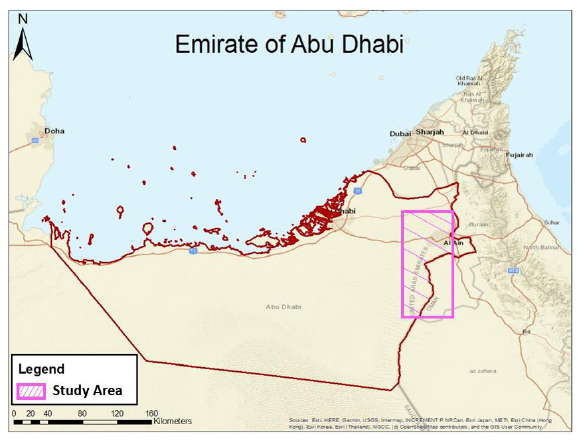
Figure 1 . Study area.